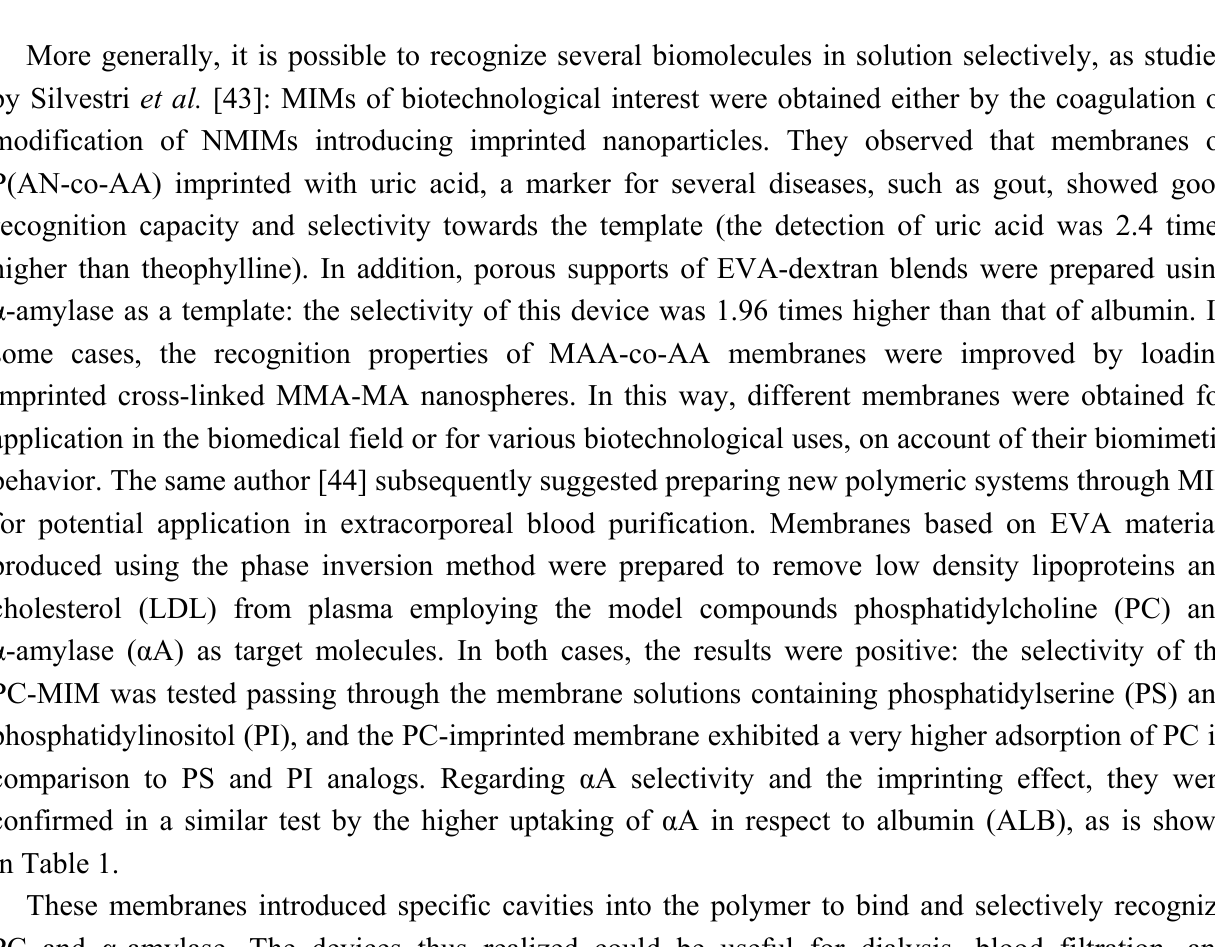
Table 1. Percentage adsorption during rebinding, selectivity, and competitive selectivity tests in respect to initial solute in the test solution of ( a ) template PC and the analogs PS and PI, ( b ) template α and the analog ALB. TABLE ( a ) % adsorbed in rebinding test % adsorbed in competitive rebinding test Molecule